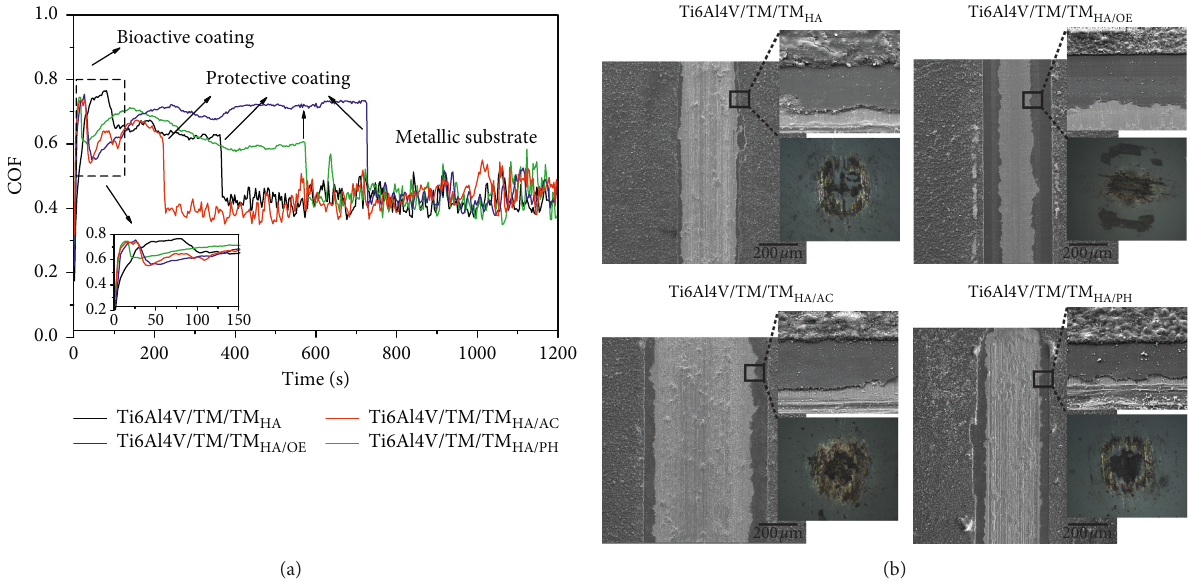
Figure 10: (a) Friction coefficient of the nonsterilized and the sterilized (by three different processes) coatings as a function of time (load of 0.3N, frequency of 1Hz, track width of 2mm, and counterbody wear